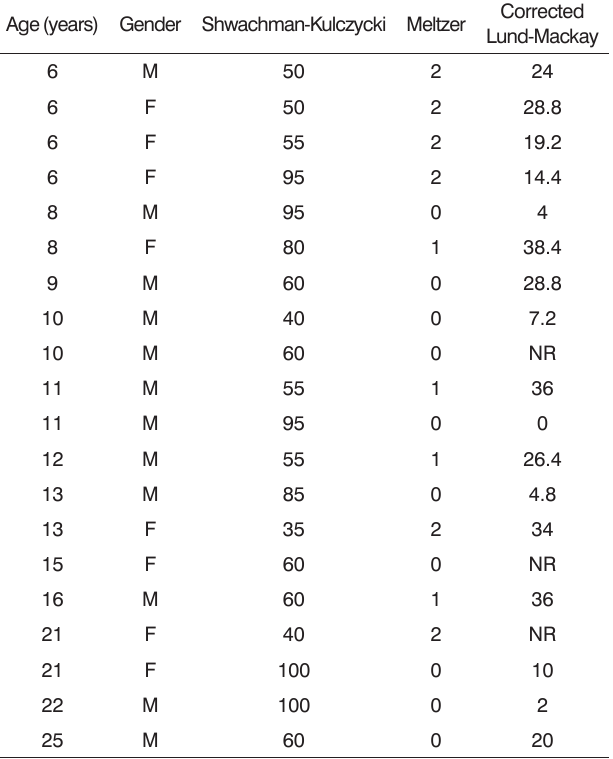
Table 1. Shwachman-Kulczycki, Meltzer and Lund-Mackay scores adjusted for each patient.